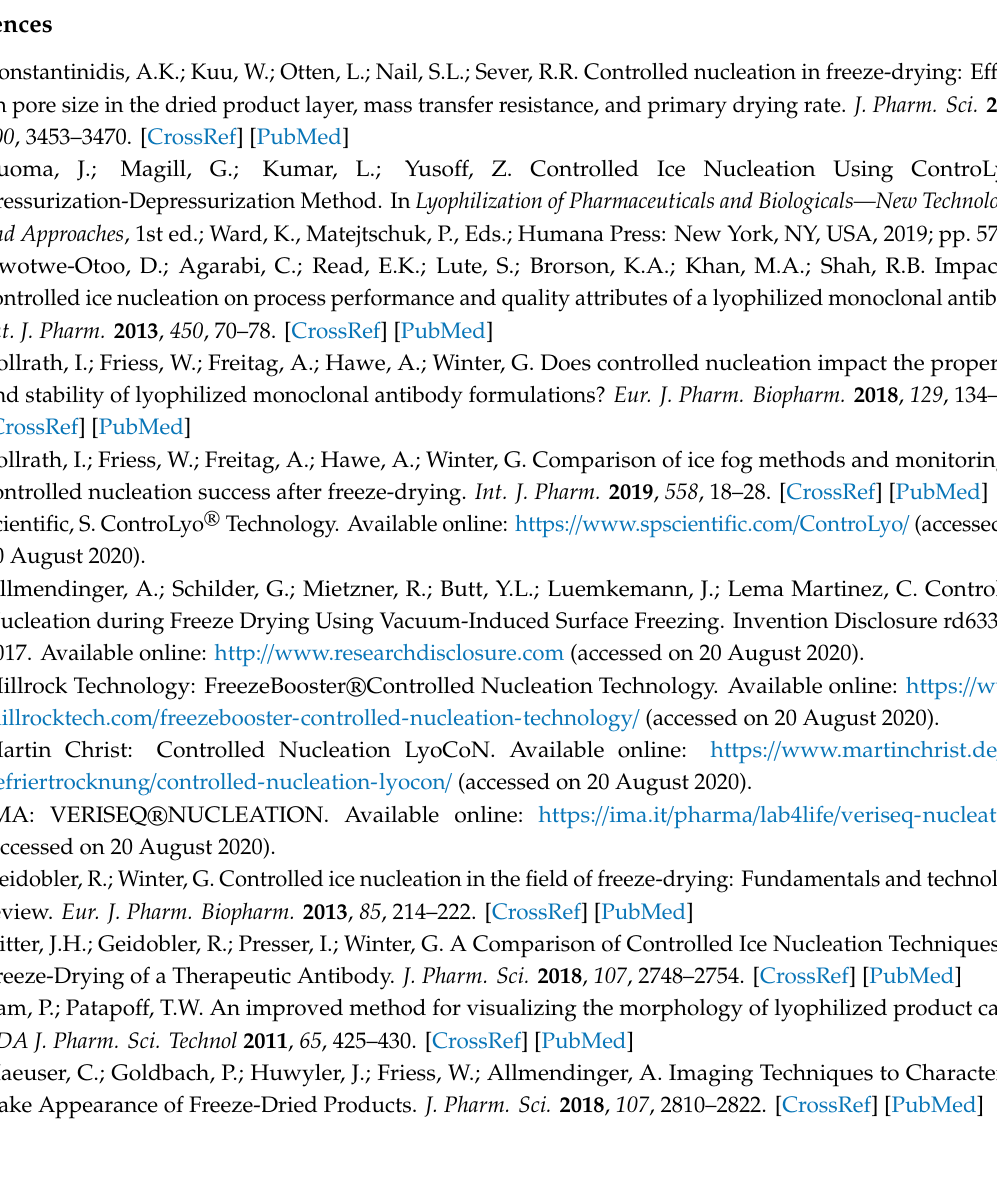
Figure A1. Solid state properties of enzyme at 2.5 mg / mL lyophilized with aggressive or conservative lyophilization cycle in 50 cc vial with “partial vacuum” or “ice fog” technique. ( 1 ) Reconstitution time, ( 2 ) specific surface area, and ( 3 ) residual moisture. Nucleation temperatures are indicated in the legend of the graphs.